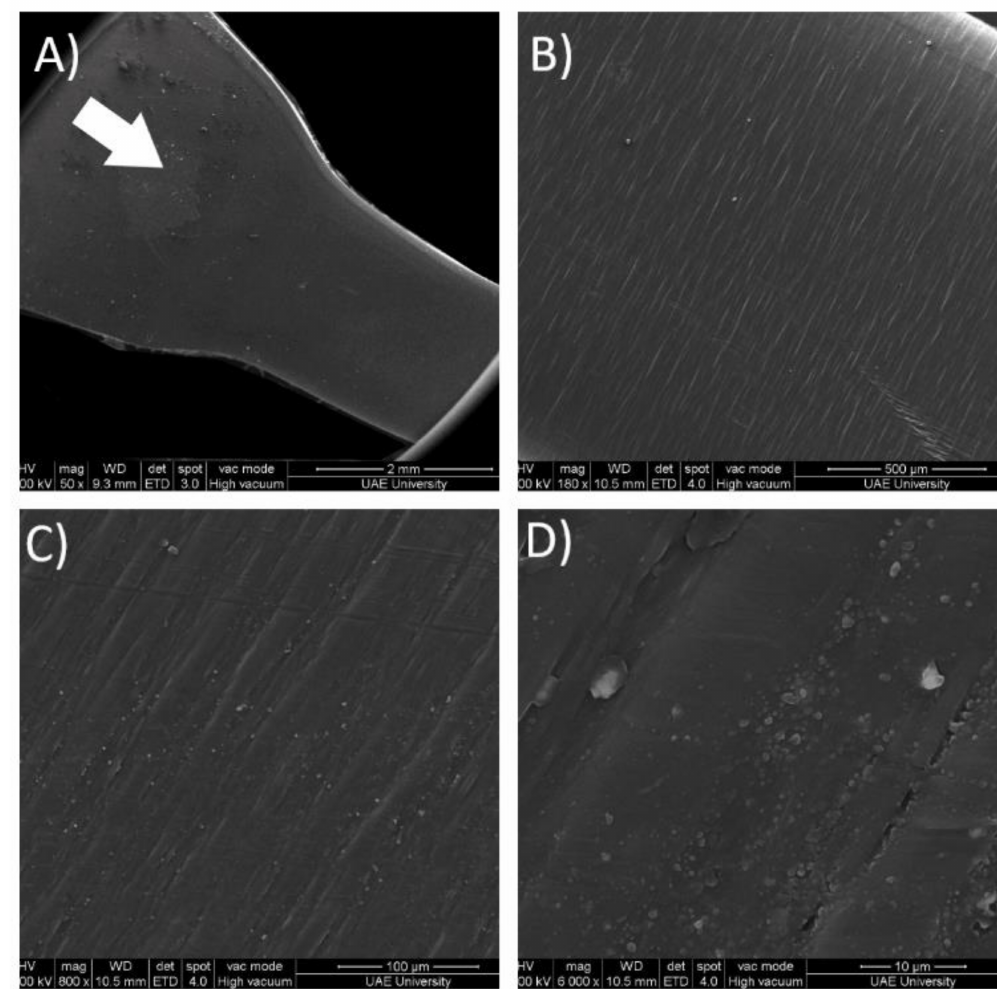
Figure 7. SEM imagining for injection-molded sample at different magnifications. ( A ) 50 × , ( B ) 180 × , ( C ) 800 × and ( D ) 6000 ×